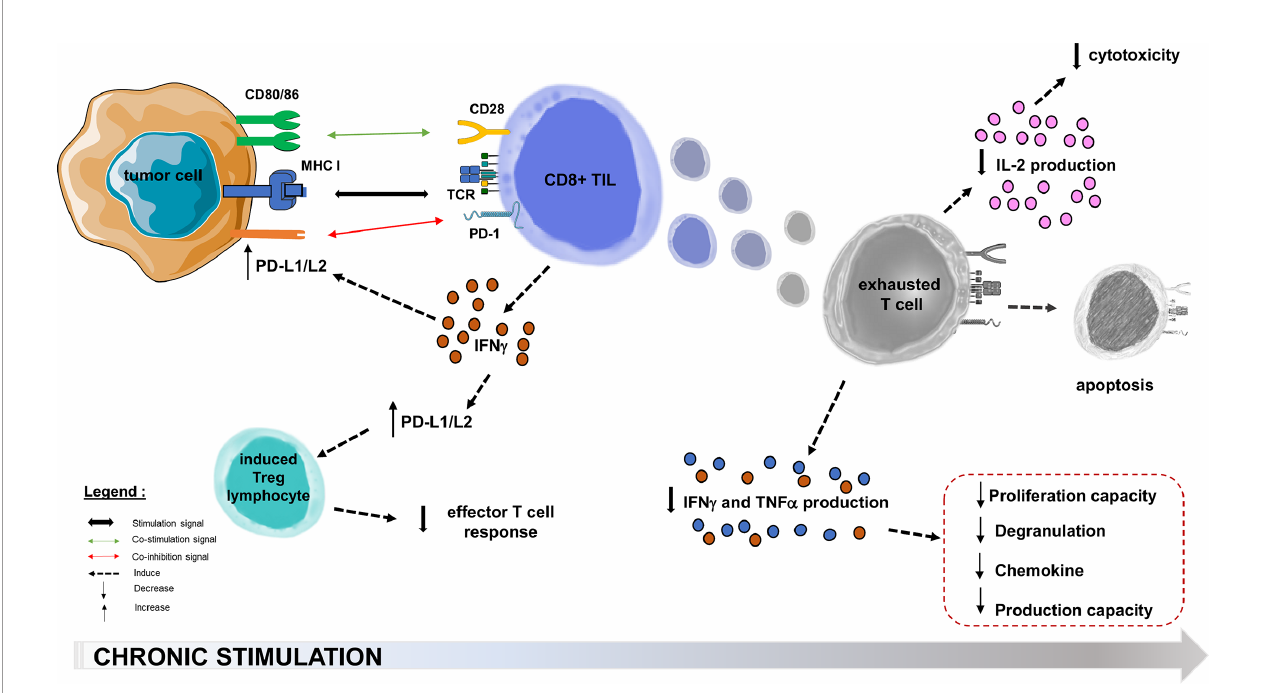
FIGURE 3 | PD-1/PD-L1/PD-L2 pathway hijacking in oncology. Immune checkpoints are exploited by solid tumors to evade or suppress the immune system. The PD-1/ PD-L1 co-inhibition axis, within the tumor microenvironment, will allow many PD-L1 tumor cells to escape the immune system through multiple mechanisms. One of these is the decrease of effector functions of cytotoxic TLs, directed against the tumor antigen by inducing their functional depletion (exhaustion), reducing their cytokines (IL-2) production ability, their high proliferation capacity, their cytotoxic activity and consequently the resistance to tumor cell lysis. The second step is the functional alterations in the production of TNF a , IFN g , b − chemokines, and degranulation. In the most terminal stages of depletion, these cells may enter apoptosis, probably as a consequence of over-stimulation. PD-L1 role is also to maintain and induce tumor-associated regulatory T-cells (induced Tregs), by promoting their switching from naive CD4+ TLs. In fi ltration of their microenvironment by activated TLs producing pro-in fl ammatory cytokines such as IFN g enhances PD-L1 upregulation in tumor cells. This feedback loop is thought to be a mechanism of adaptive immune resistance by the tumor. APC, Antigen Presenting Cell; CTLA-4, Cytotoxic T lymphocyte-associated Antigen 4; IFN g , Interferon Gamma; IL-2, Interleukine 2; MHC, Major Histocompatibility Complex; PD-1, Programmed Death 1; PD-L1, Programmed Death Ligand 1; TCR, T-cell Receptor; TIL, Tumor-in fi ltrating Lymphocyte; TNF a , Tumor Necrosis Factor Alpha; Treg, Regulatory T